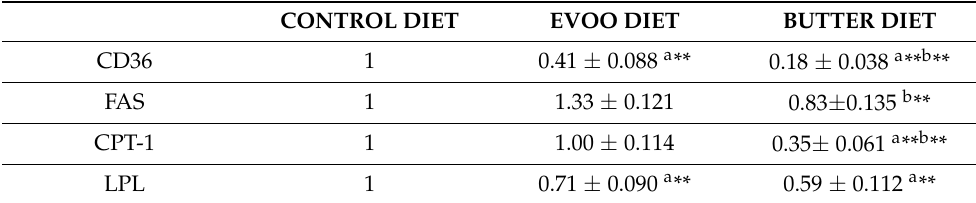
Table 4. Mean values ± SEMs of mRNA expression (relative RNA level) of different genes regulators of the lipid metabolism in skeletal muscle samples of the three groups of animals (the control, butter, and EVOO diets). a: significant differences between EVOO, butter, and control. b: significant differences between EVOO and butter. ** p <